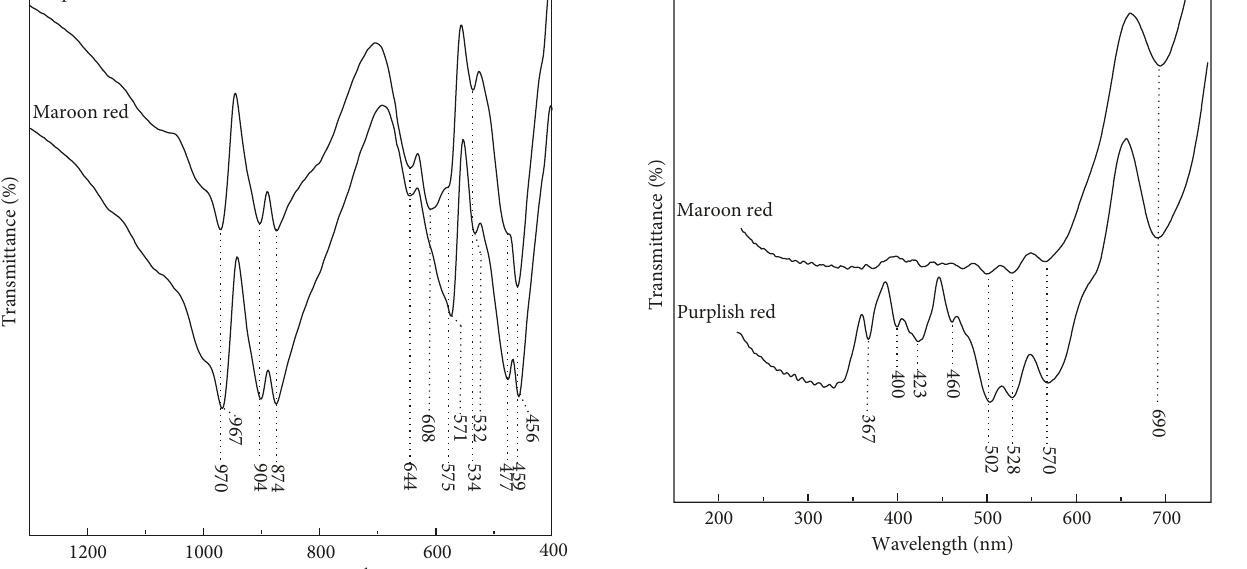
Figure 4: Ultraviolet-visible spectra of the purplish-red and ma- roon-red